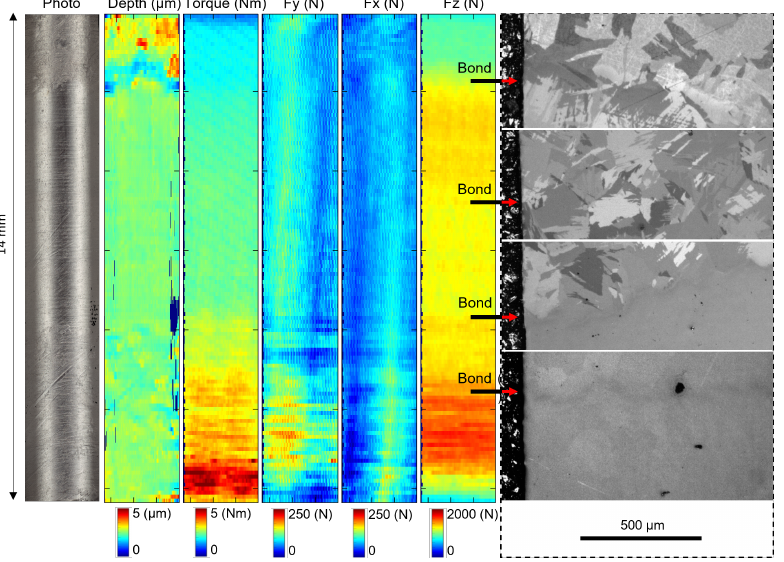
Figure 5. A photograph of the drilled surface, micrographs of the bond interfaces and depth, torque, Fy, Fx and Fz maps for holes drilled at 1845 RPM and F rev = 0.131 mm/rev in the Ti-CP-Ti-6242-Ti-64- Ti-5553-Beta C workpiece (five alloy